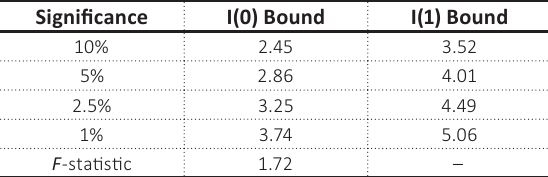
Table 4. Bounds test